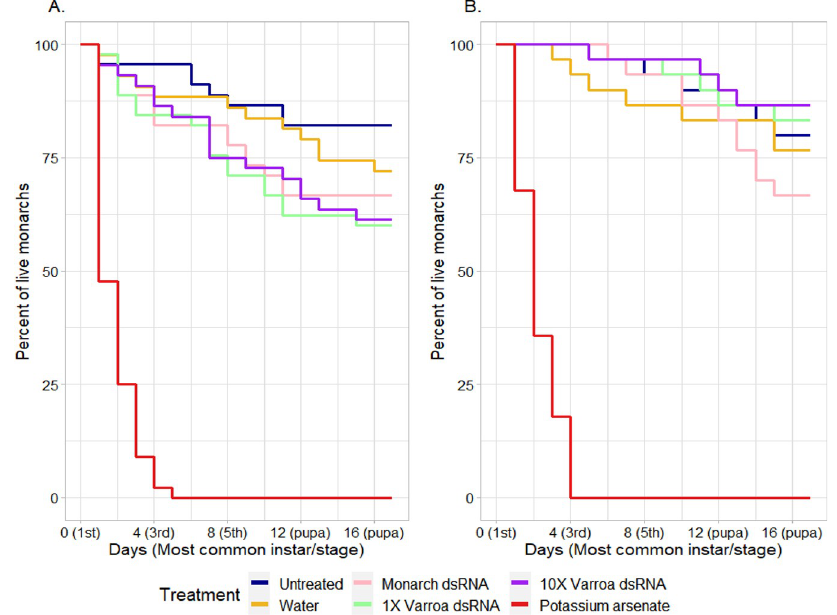
Fig 1. Monarch mean percent mortality over time, from neonate larvae to pupae, with data combined over all bioassay runs. Larvae were fed common (A) or tropical (B) milkweed leaves that were untreated (UN), treated with deionized water (WT), 5 mg/mL monarch-active dsRNA solution (MB), 2.1 (VL) and 21 (VH) mg/mL Varroa-active dsRNA solutions, or 1 mg/mL potassium arsenate solution (KA). Missing larvae (including 1 larva that was accidentally killed and five that went missing) were excluded from analysis.